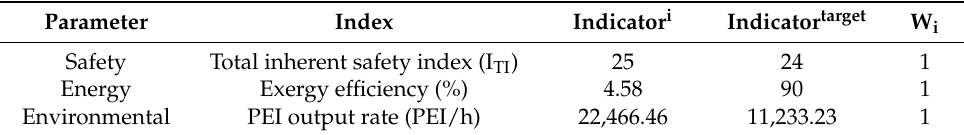
Table 6. Targeting and weighting factor for each technical